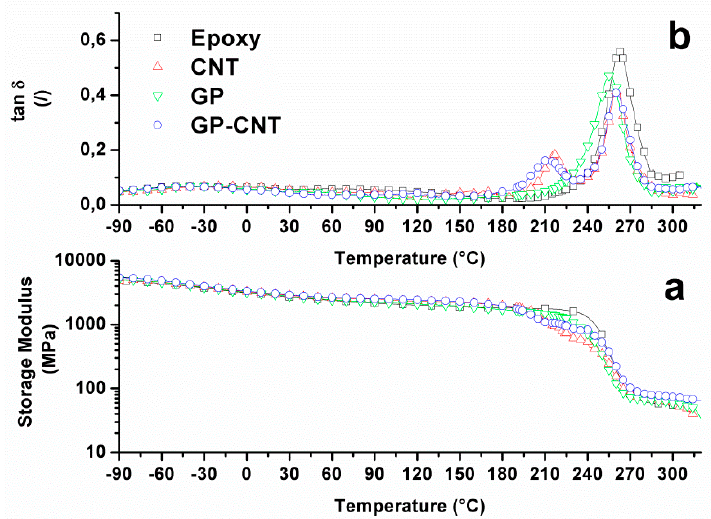
Figure 6. DMA analysis for the filled and unfilled epoxy resin ( a ): storage modulus ( b ): Loss factor (tan δ ).